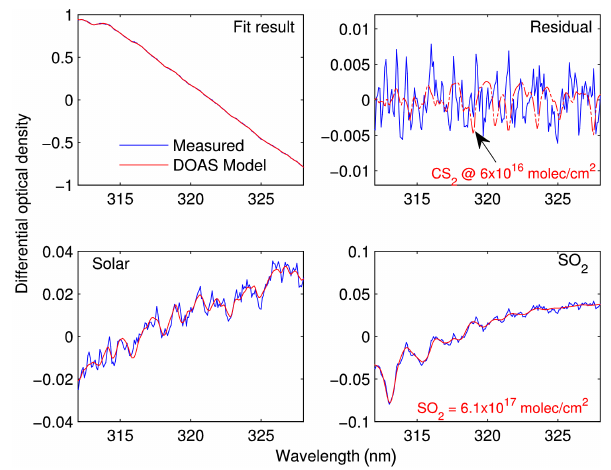
Figure 6. Evaluation of the measured spectra for CS 2 absorption. Here, a solar spectrum was included in the fit to remove features associated with scattered solar radiation entering the instrument’s light path (Ring spectrum not shown for clarity). CS 2 was not de- tected during the experiments, but an upper limit could be deter- mined from the fit residual. Here, the residual is compared to the absorption features associated with a hypothetical column density of 6 × 10 16 CS 2 moleccm − 2